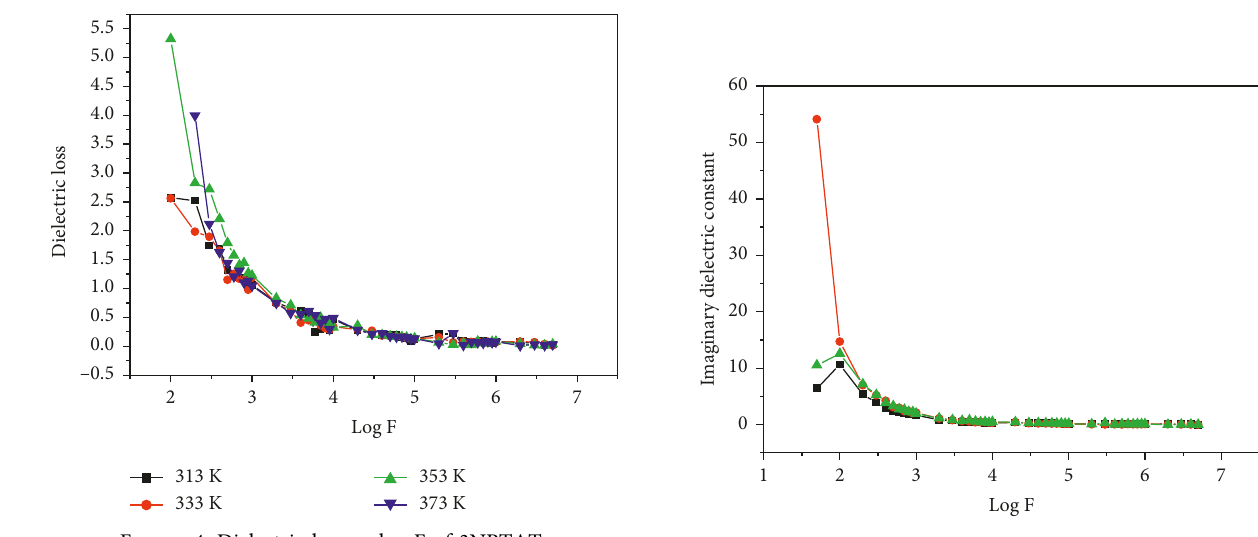
Figure 5: Real dielectric constant ( ε ) vs log F.